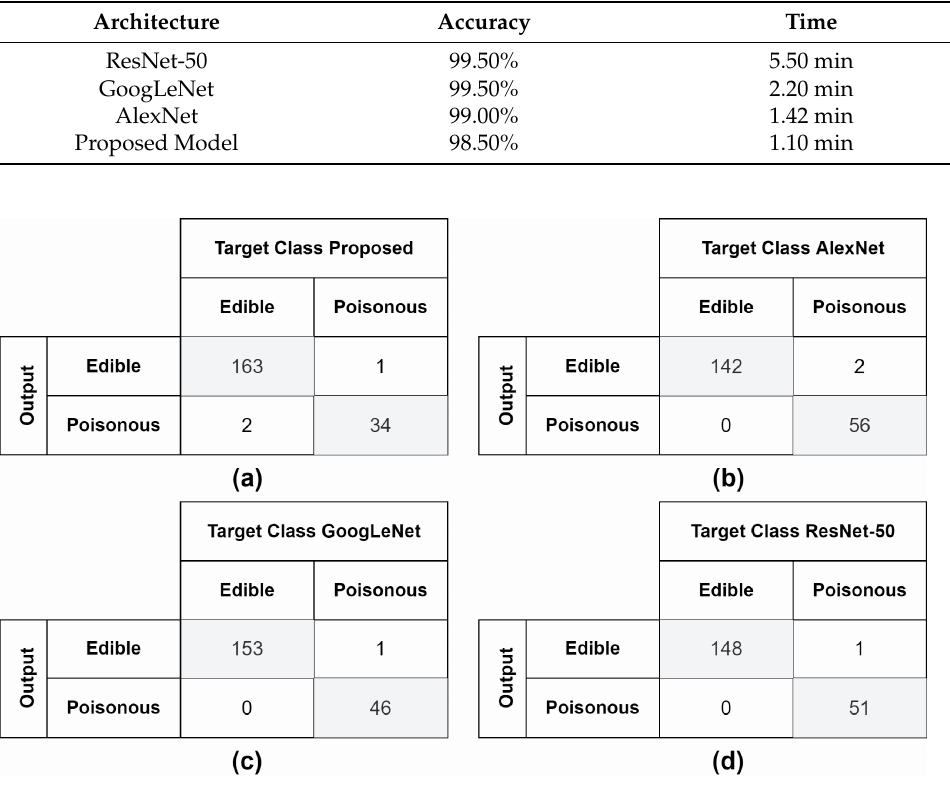
Figure 14. The confusion matrix of the CNN analysis: ( a ) proposed model; ( b ) AlexNet; ( c ) Goog- LeNet; ( d ) ResNet-50.